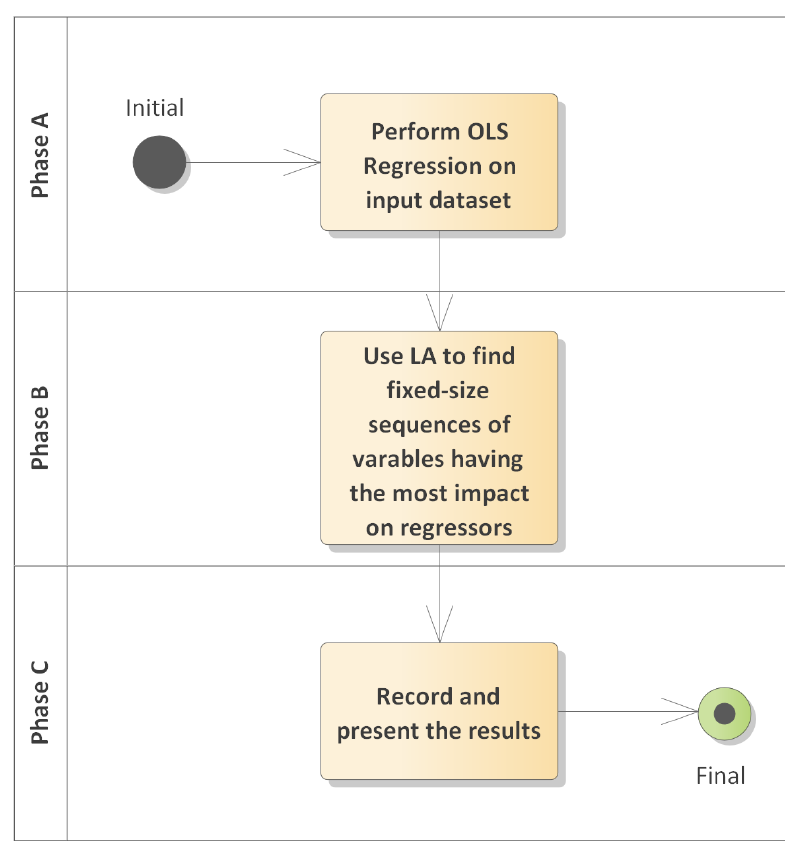
Figure 1. Orion activity diagram.